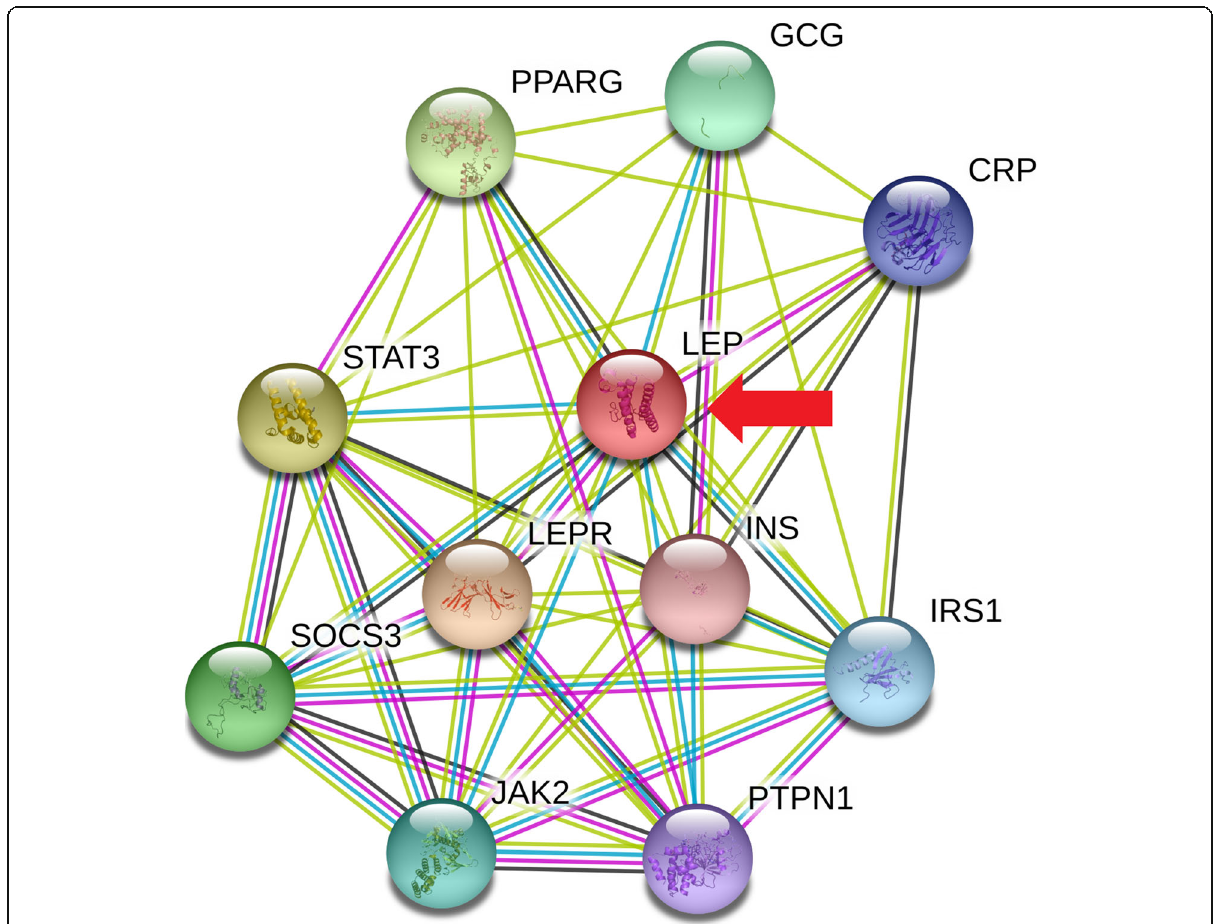
Fig. 7 Functional association network of the leptin with other important proteins in the cellular metabolic system. All known and predicted protein-protein interaction network are shown between leptin and other related proteins through variable extending threads. The red arrow refers to the targeted leptin protein. This network is generated by String 10